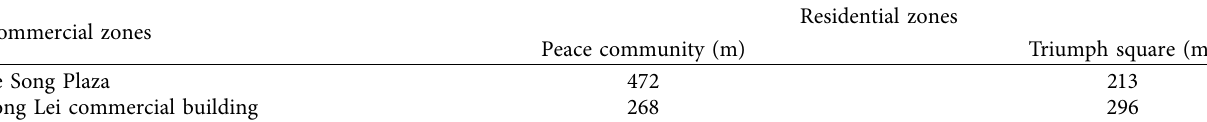
Table 1: Walking distance after